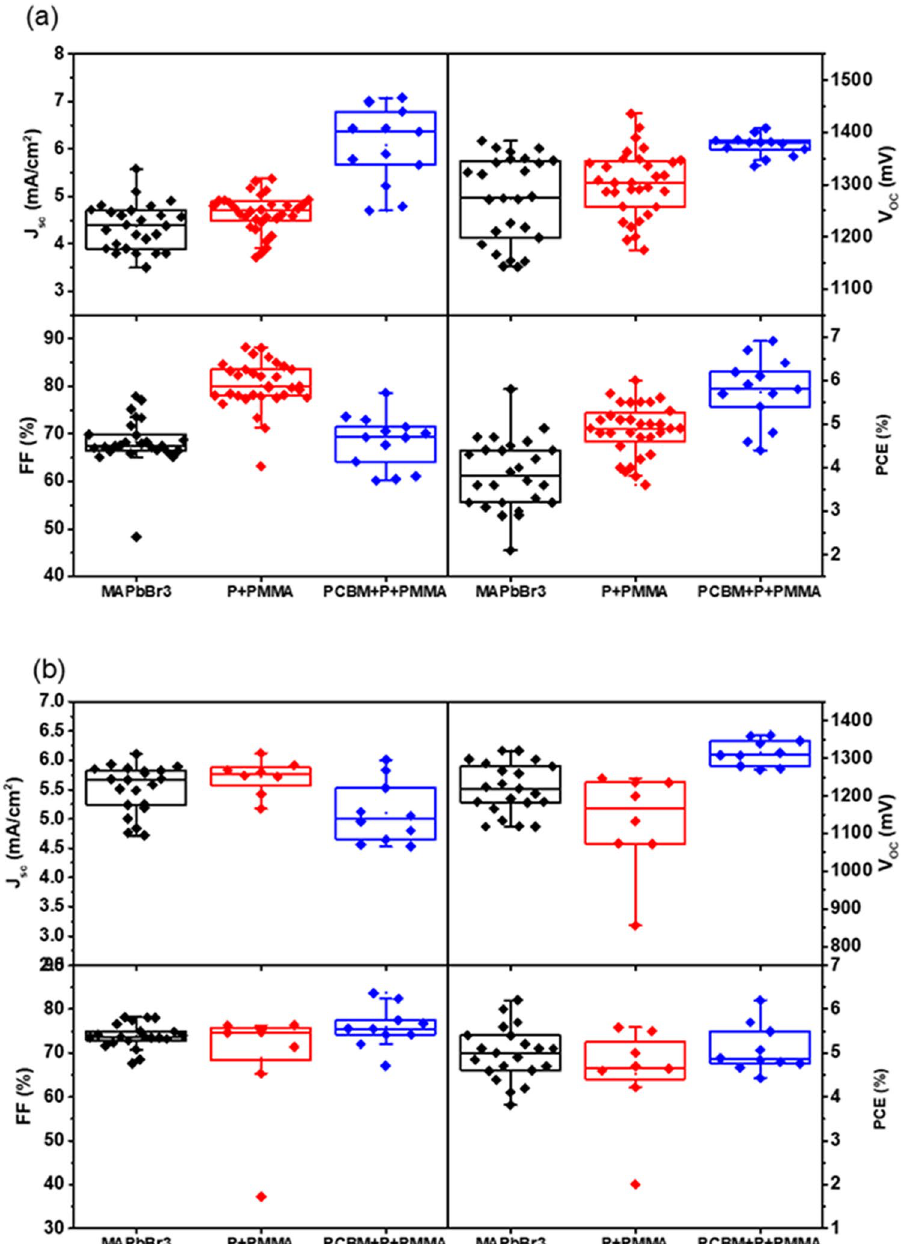
Figure 2. Statistical distribution of the photovoltaic parameters for cells with/without PMMA and PCBM passivation layers: ( a ) anti-solvent deposited MAPbBr 3 layers, ( b ) FIRA-annealed MAPbBr 3